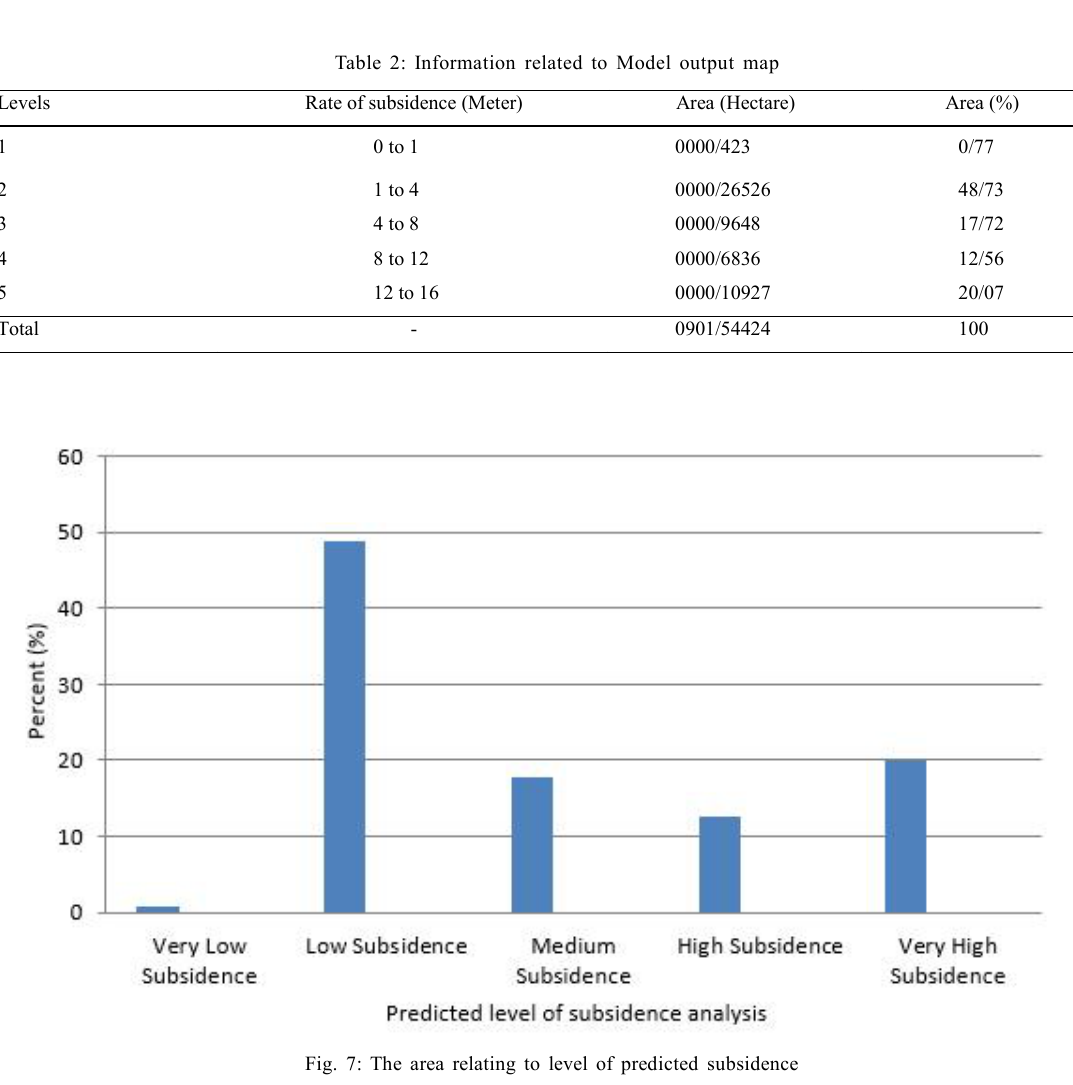
Fig. 7: The area relating to level of predicted